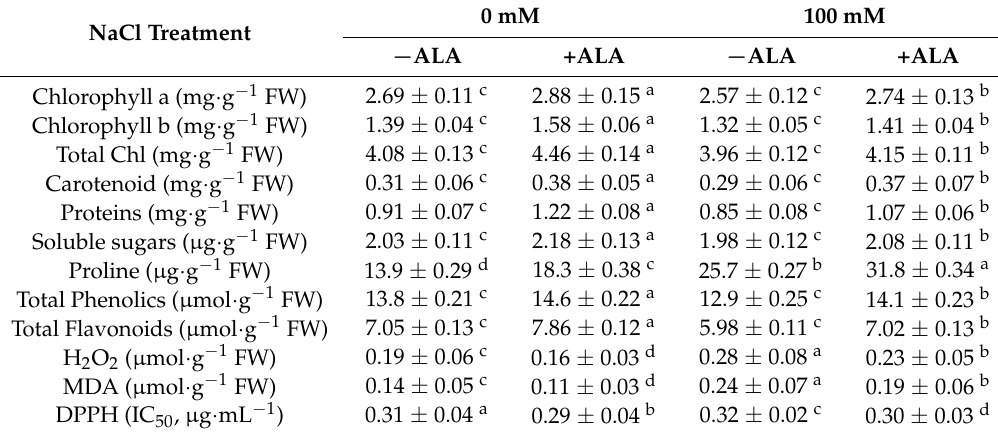
Table 6. Contents of chlorophyll, carotenoids, proteins, sugars, proline, phenolics, flavonoids, H 2 O 2 , MDA and antioxidant activity (DPPH) in leaves of Urbanowicki cultivar under salt and/or ALA (7 ppm) treatments.